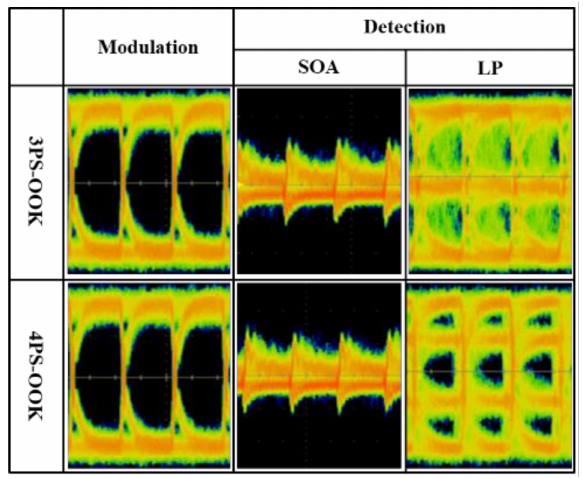
Figure 4. Eye diagrams of the proposed 3PS-OOK and 4PS-OOK transmissions without the scintilla- tion